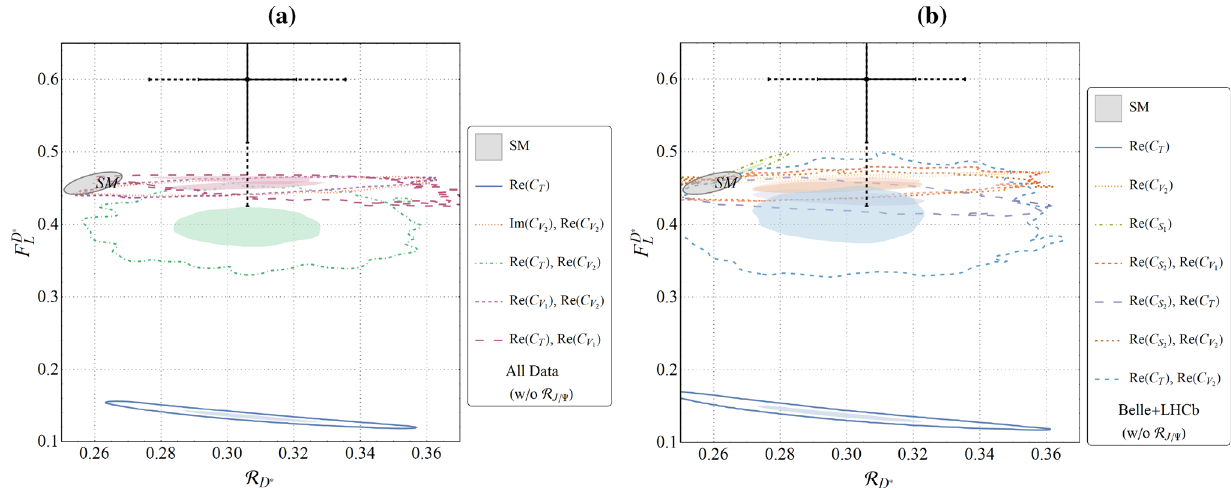
Fig. 7 Correlation plot of R D ∗ vs. F D ∗ previously showed in Figs. 3, 4, 5, and 6. We overlap these plots with the experimental results of R D ∗ (Eq. (1)) and F D ∗